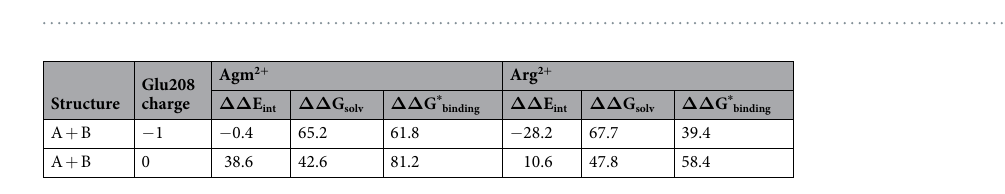
Table 4. Contributions to the free energies of binding calculated using MM-PBSA. Δ E int , Δ G solv,complex , Δ G solv,p , and Δ G solv,ligand for Arg + , Arg 2 + , and Agm 2 + .